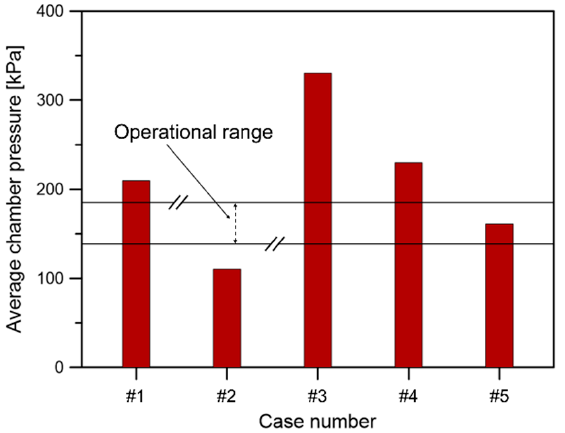
Figure 13. Average chamber pressure during the EPB shield advance after the first 100 mm.